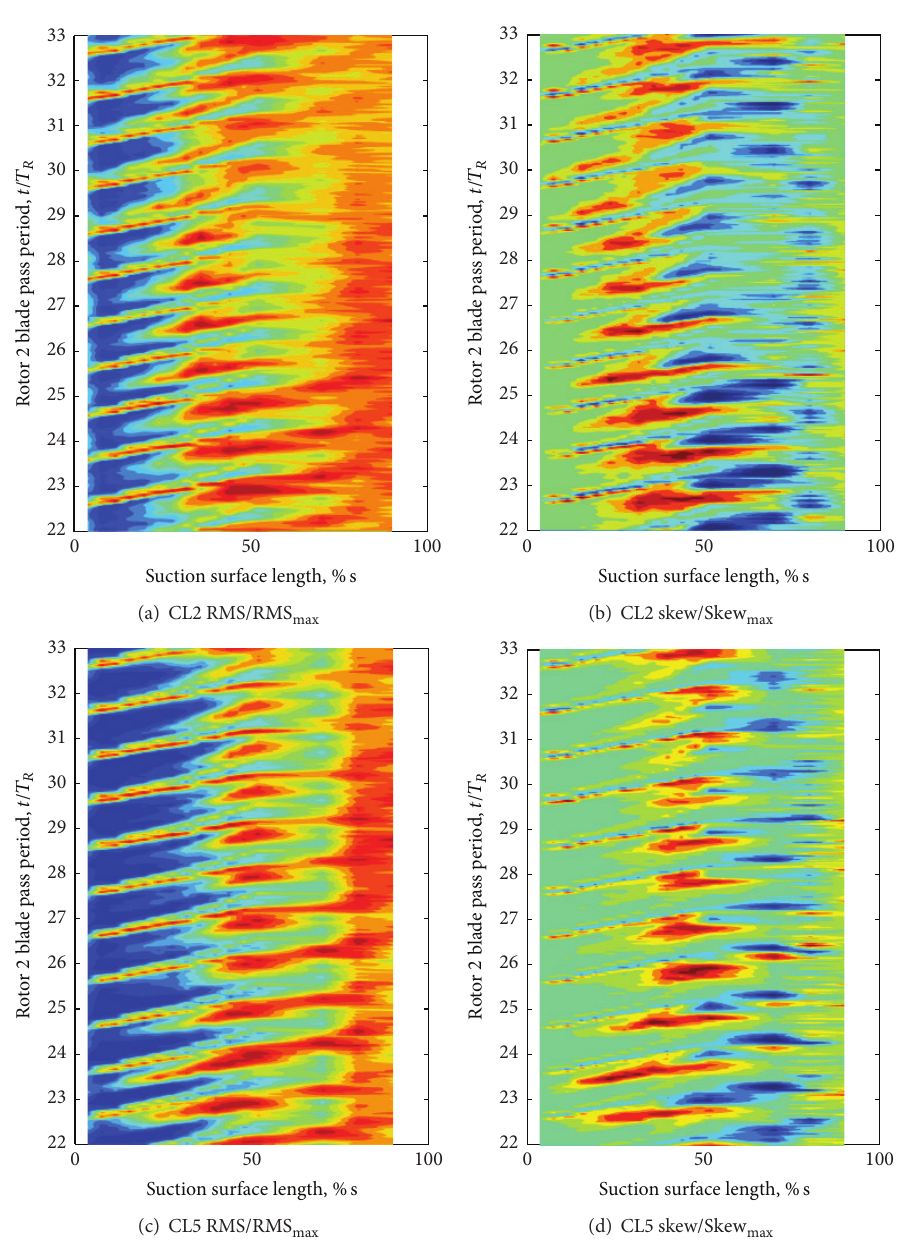
Figure 7: RMS (a, c) and skew (b, d) of Stator 2 QWSS for two clocking configurations at 50% span for 30% SM.